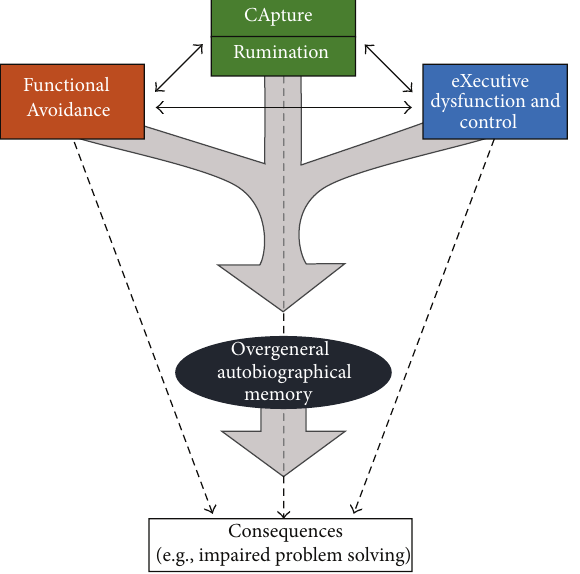
Figure 1: The CaR-FA-X model. Three factors (CApture/Rumi- nation, Functional Avoidance, and impaired eXecutive function and control) interact to decrease the specificity of retrieved autobio- graphical memories. These less specific memories and the three factors per se can then have effects on cognition and